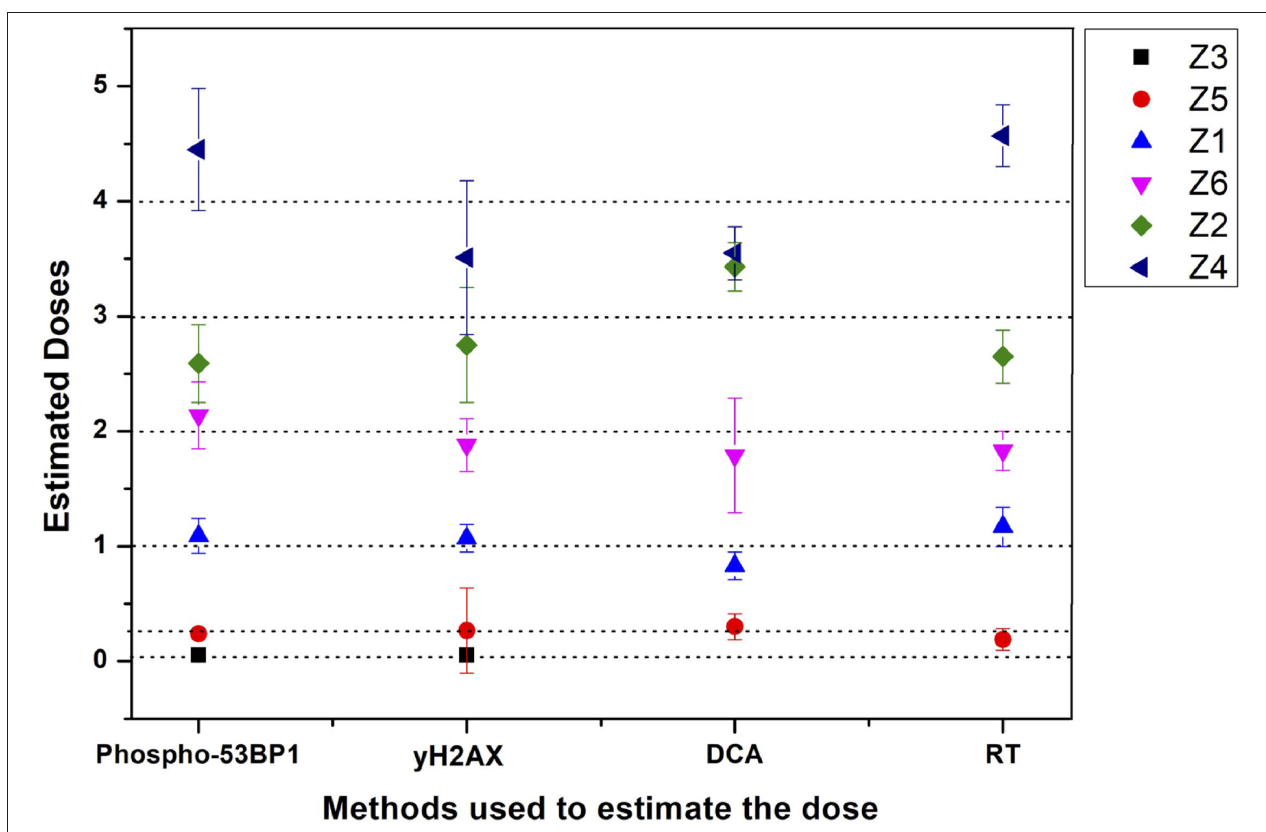
FIGURE 6 | Graphical illustration of the estimated doses of blinded samples (Z1–Z6) by immunofluorescence (phospho-53BP1 and γ H2AX) and cytogenetic (dicentric and reciprocal translocation) assays.